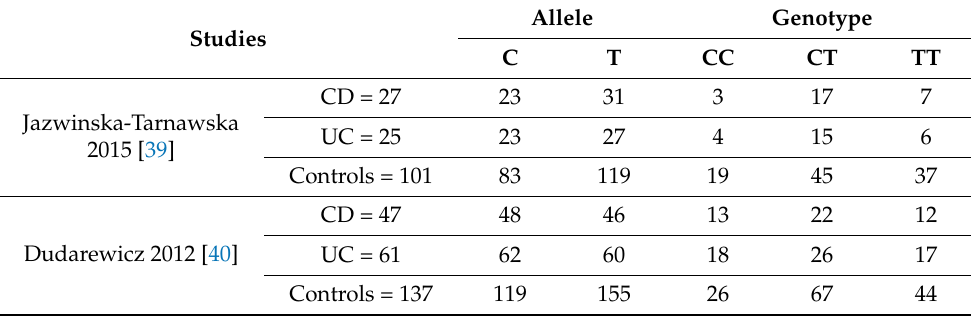
Table 1. Distribution of C3435T alleles and genotypes (cases and controls) in included studies. Allele Genotype Studies C T CC CT